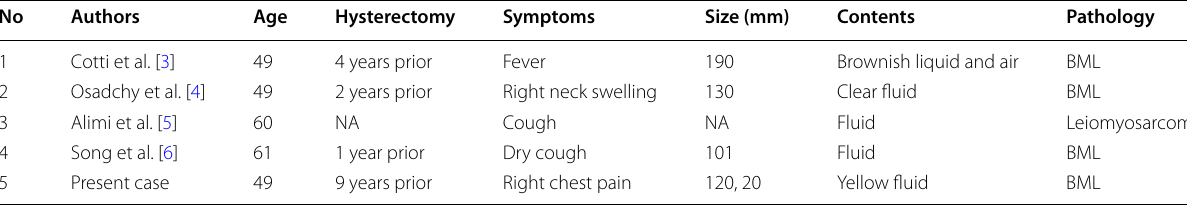
The diameter of the fluid-containing tumors in the four cases was 101–190 mm. Malignant transformation was found in one case out of four cases of fluid-containing tumor BML benign metastasizing